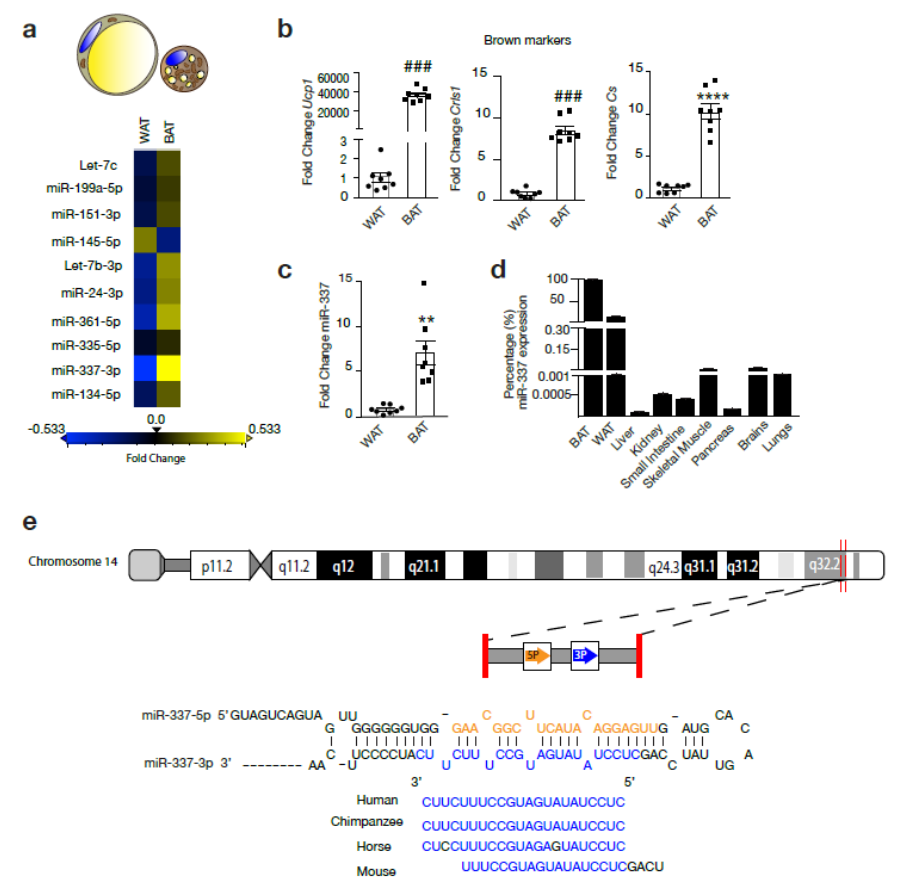
Figure 1. miR-337-3p is a potential regulator of browning of adipose tissue. ( a ) Representative heatmap showing the results of RT-PCR analysis used to screen a panel of microRNAs (miR) in mouse white adipose tissue (WAT) and brown adipose tissue (BAT): Let-7c, miR-199a-5p, miR-151-3p, miR-145-5p, Let-7b-3p, miR-24-3p, miR-361-5p, miR-335-5p, miR-337-3p, miR-134-5p. Real-time PCR was performed using the miRCURY LNA miR PCR Assay and normalized to U6 RNA and relative to WAT. Differentially expressed miR (fold change ≥0.5) are indicated in yellow, which represents upregulated miRNA in BAT compared to WAT, and in blue are the downregulated miRs (fold change ≤− 0.5) in BAT compared to WAT. N = 3/group. ( b ) RT-PCR analysis of transcript abundance of BAT thermogenic and mitochondrial markers Ucp1, Cs, and Crls1 in BAT compared to WAT. mRNA expression values were normalized to L7 mRNA. N = 8/group. ( c ) RT-PCR analysis of mmu-miR-337-3p expression in mouse WAT and BAT normalized to U6 RNA. N = 8/group ( d ) RT-PCR analysis of mmu-miR-337-3p abundance in BAT, WAT, liver, kidney, small intestine, skeletal muscle, pancreas, brains, and lungs presented as percentage of mmu-miR-337-3p transcript abundance from its expression in BAT. Expression of miR-337-3p in BAT is set to 100%. ( e ) Representative image of the genomic mapping of miR-337-3p in humans and conservation of its seed sequence among species. Data are presented as means ± SEM; individual data points are given by the dot plot. Either Mann – Whitney-U or Independent sample t -test was used to assess differences in expression levels. ### p < 0.001 Mann – Whitney-U, ** p < 0.01 **** p < 0.0001 Independent sample t -test, equal variances not assumed. n, number of biological replicas; WAT, white adipose tissue; BAT, brown adipose tissue; Ucp1 , uncoupling protein-1; Crls1 , cardiolipin synthase 1; Cs , Citrate synthase; RT-PCR, quantitative real time-polymerase chain